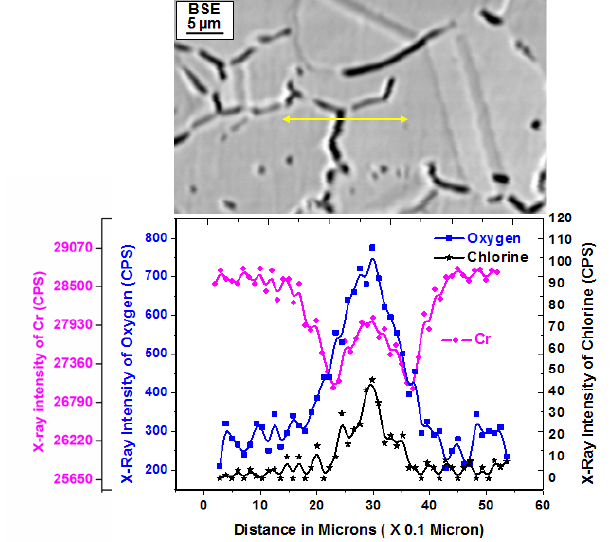
Figure 5: EPMA Line profile of the elements O, Cl and Cr across the grain boundary demonstrates as reflected in the X-ray